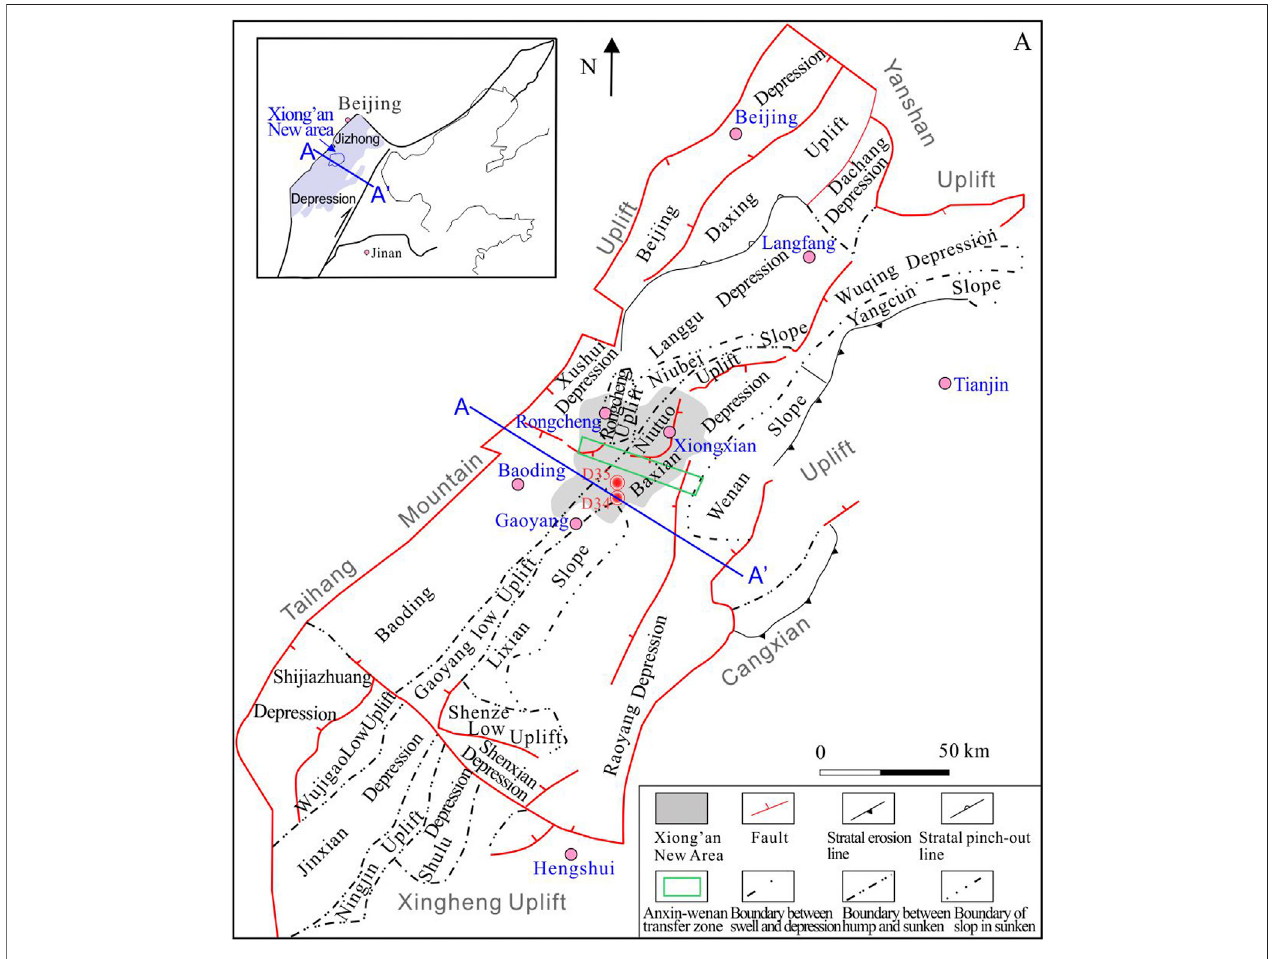
FIGURE 1 | Structural location of Xiong ’ an New Area in the Jizhong